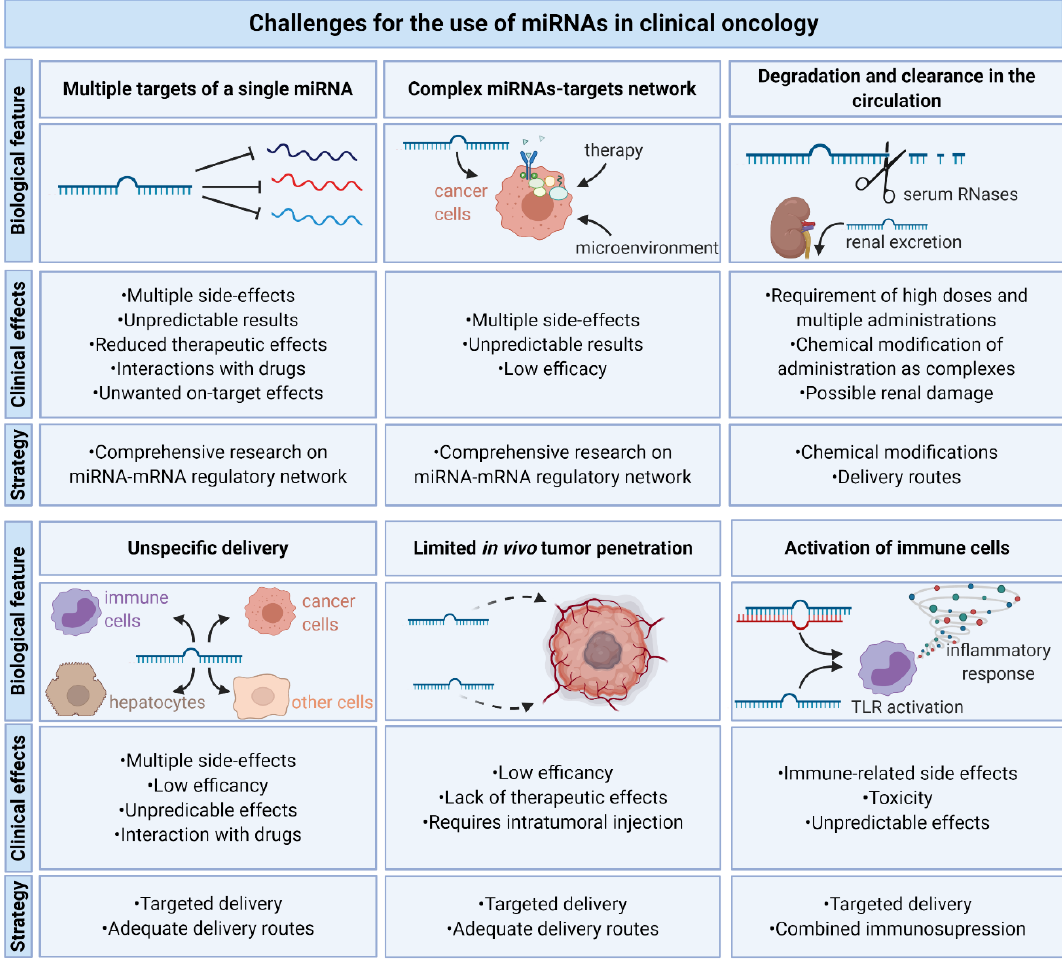
Figure 5. Challenges for the use of miRNAs in clinical oncology. Biological features of miRNAs include multiple targets, the complexity of the miRNAs–mRNAs network, the degradation by RNases and clearance in the circulation via renal excretion, unspecific delivery—not only to their destination, but also to healthy unaffected tissue including hepatocytes, limited in vivo tumor penetration and the activation of immune cells. This leads to a lack of therapy e ffi ciency and there is a need for further comprehensive research on the miRNA–mRNA network and miRNAs’ delivery methods to overcome